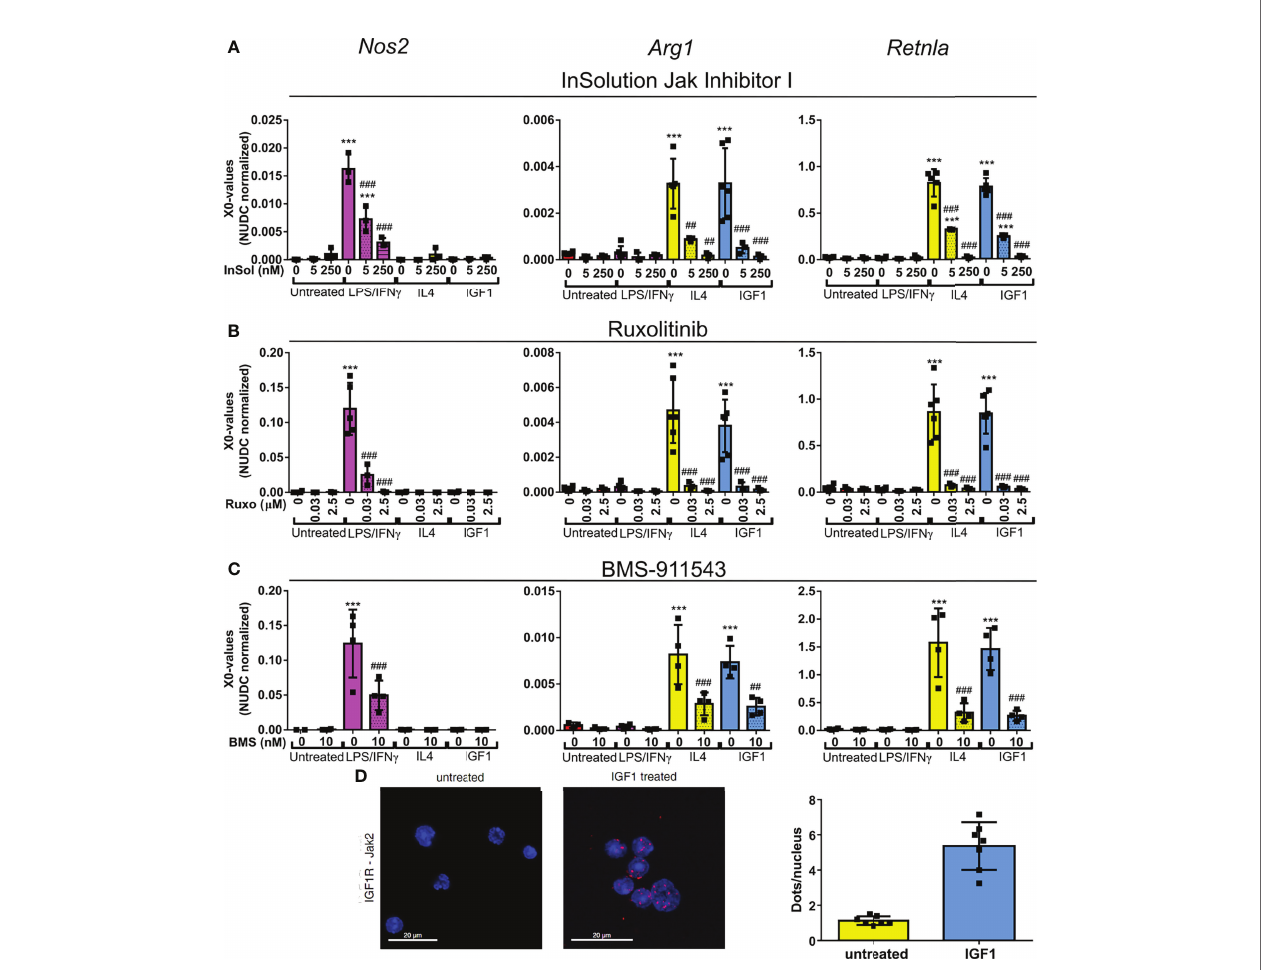
FIGURE 4 | IGF1 induces neutrophil polarization via JAK activation (A – C) Quantitative RT-PCR analysis of bone marrow derived neutrophils untreated, or treated for 4 hours with LPS/IFN g (10/2 ng/mL), IL4 (20 ng/mL) or IGF1 (10 ng/mL) in the presence or absence of the JAK inhibitors InSolution Jak Inhibitor 1 (Insol) (A) , Ruxolitinib (Ruxo) (B) or BMS-911543 (BMS) (C) shows that neutrophil polarization is dependent on Jak activation. EC 50 values of the JAK inhibitors are shown in Table 1 . X0 values normalized to Nudc (nudC nuclear distribution protein) expression of single measurements are shown. (D) Representative images and analysis of untreated and IGF1 treated neutrophils after proximity ligation assay with JAK2 and IGF1 receptor (IGF1R). Proximity ligation assay analysis of IGF1R with JAK1, JAK3 and TYK2 are shown in Figure S1 . LPS, Lipopolysaccharide; IFN g , interferon-gamma; IL4, Interleukin 4; IGF1, Insulin-like growth factor 1; Nos2 , nitric oxide synthase 2; Arg1 , Arginase 1; Retnla , resistin like alpha. Single measurements are shown. Bars represent mean ± SD. *p<0.05, **p<0.01 and ***p<0.001 when compared to untreated without inhibitor. # p<0.05, ## p<0.01 and ### p<0.001 when compared to the same treatment without